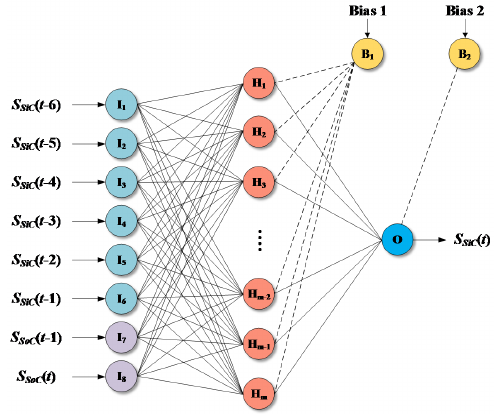
Figure 4. An example of MLP model architecture.